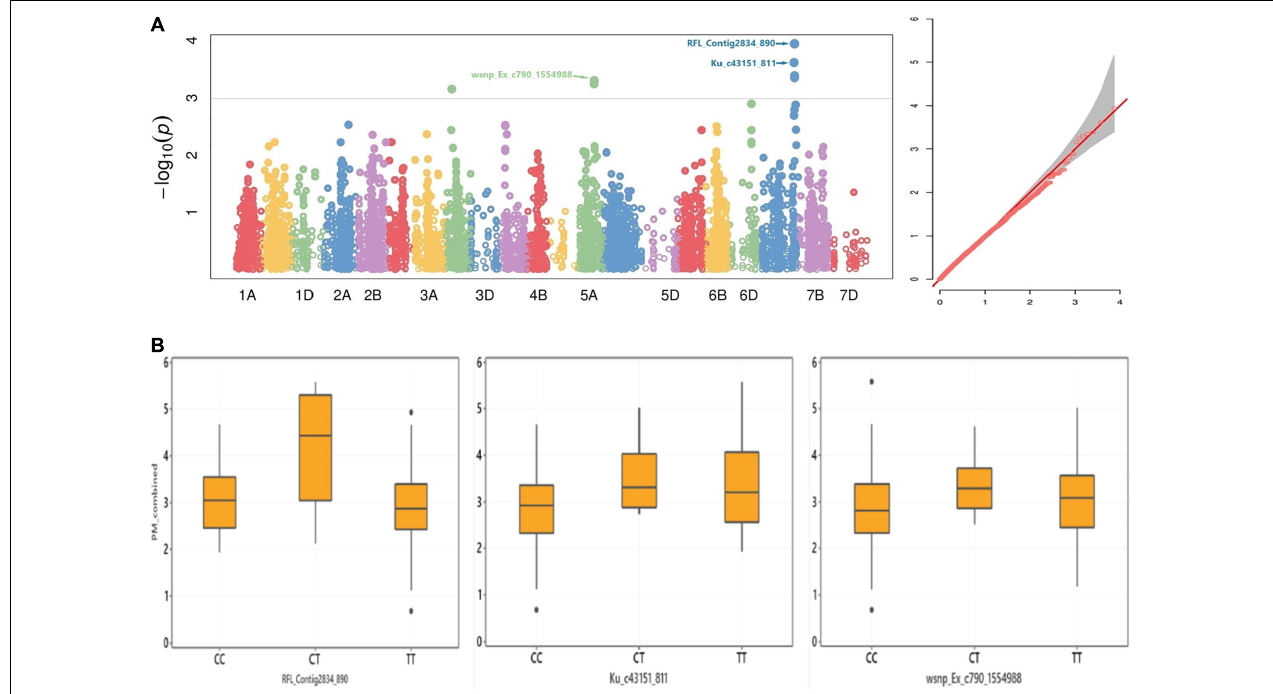
FIGURE 4 | (A) Manhattan (left) and Q–Q (right) plots for GWAS result of adult-plant resistance response to PM and (B) box plots for STB resistance values grouped by alleles of the SNP markers RFL_Contig2834_890 , Ku_c43151_811 , and wsnp_Ex_c790_1554988